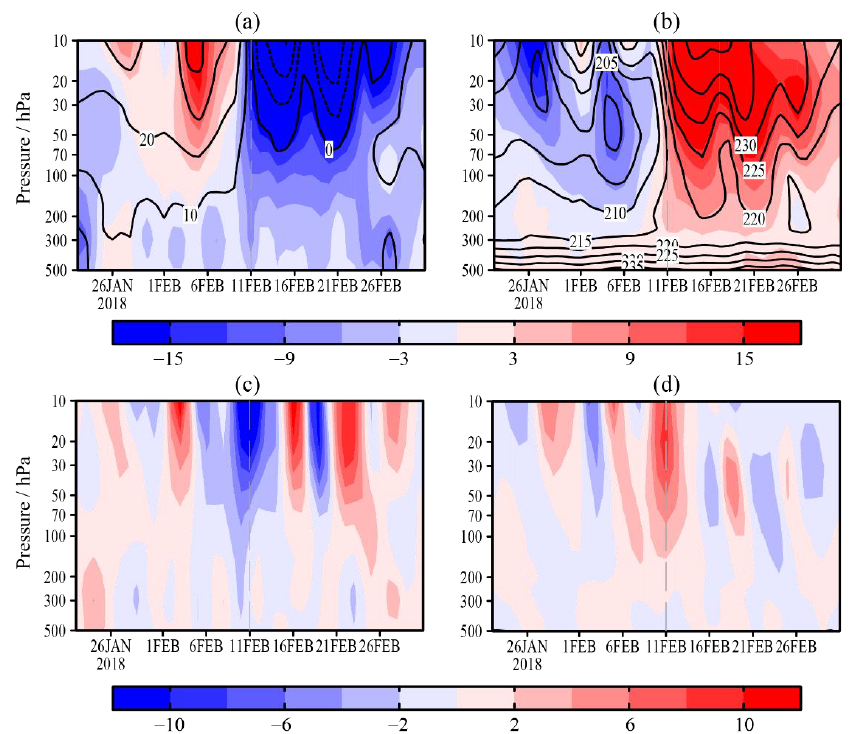
Figure 2. Temporal evolutions of ( a ) the zonal-mean zonal wind (contour, unit: m s − 1 ) with its anomaly (shading, unit: m s − 1 ) and ( c ) tendency (unit: m s − 1 d − 1 ) averaged in 60–75 ◦ N during the period 22 January–3 March 2018. ( b , d ) As in ( a , c ), but for ( b ) the air temperature (contour, unit: K) with its anomaly (shading, unit: K) and ( d ) tendency (shading, unit: K d − 1 ) averaged in the polar region (0–360 ◦ , 70–90 ◦ N).